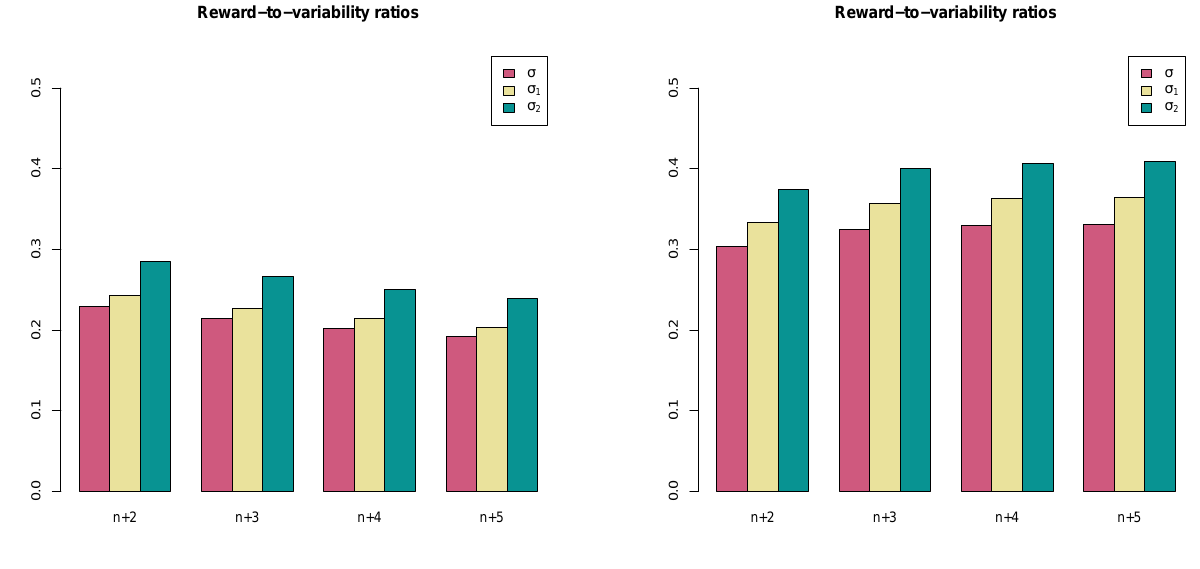
Figure 6. Comparison of reward-to-variability ratios based on corrected one-year predictions for periods n + 2, . . . , n + 5 and σ (red), σ 1 (yellow), and σ 2 (green). ( Left ) Short-term interest rate benchmark. ( Right ) Inflation